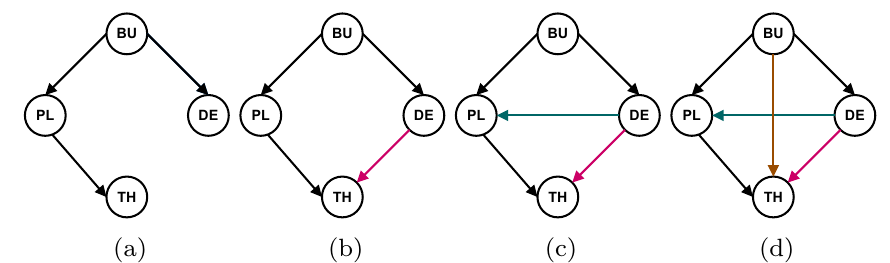
Fig. 8 Maximum scored DAG for BNSL by adding the edges without forming cycles (a) Resultant DSG of − 13.1598) (b) Add an edge between De to Th (Score chow-liu algorithm (Score = − 14.1598) (d) Add an edge between BU to Th (Score edge between De to PL (Score =